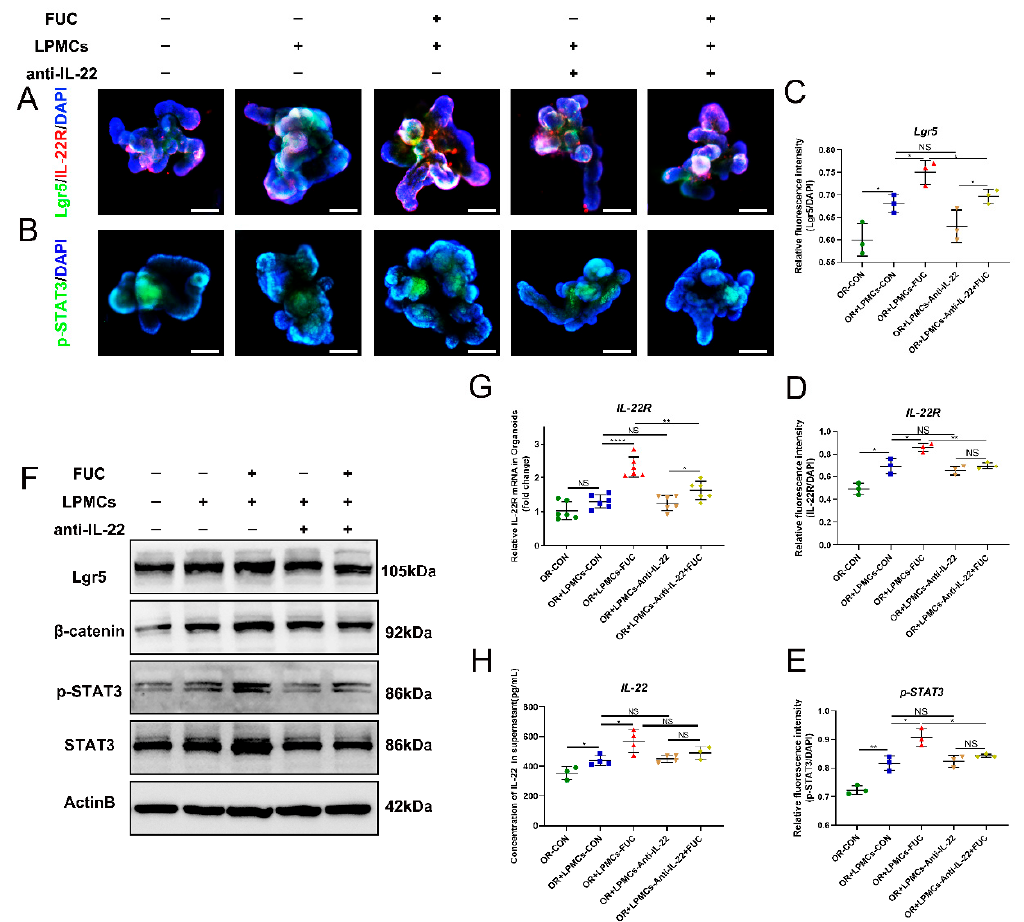
Figure 7. IL-22R-p-STAT3 pathway mediated by IL-22 secretion of LPMCs in ISC proliferation after L-Fucose treatment. Representative immunofluorescence images of ( A ) IL-22R (red), Lgr5 (green) and ( B ) p-STAT3 (green) in organoids (scale bar, 100 µ m). Quantitative analysis of ( C ) Lgr5, ( D ) IL-22R and ( E ) p-STAT3 fluorescence intensity in organoids. ( F ) Western blotting analysis of Lgr5, β -catenin, p-STAT3 and STAT3 in organoids. ( G ) qRT-PCR analysis of IL-22R in organoids. ( H ) ELISA analysis of IL-22 in the culture supernatant of the LPMC -organoid coculture system. Data are expressed as the mean ± SD. * p < 0.05, ** p < 0.01, **** p < 0.0001; NS, no significance. +, with. − , without.